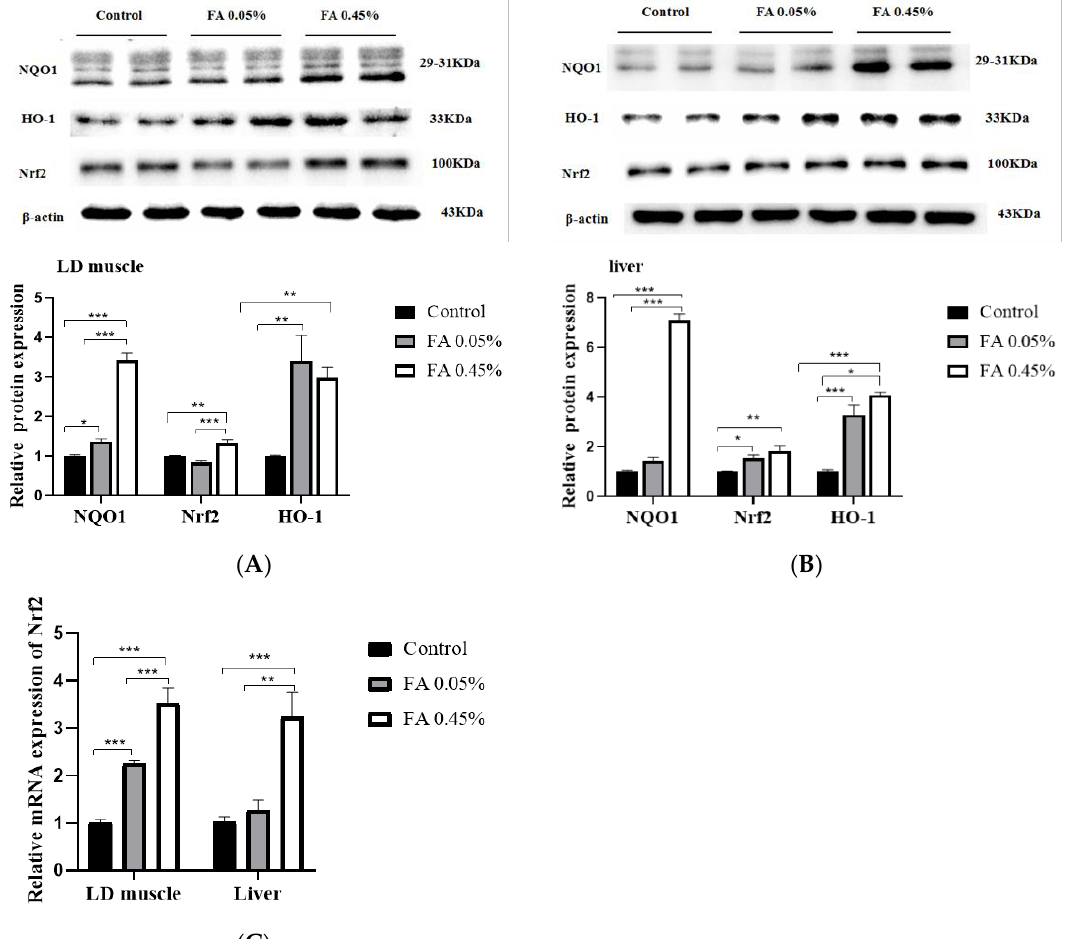
Figure 2. Effect of dietary FA supplementation on the expression of Nrf2-ARE signal components. ( A , B ) The protein levels of NQO1, Nrf2, and HO-1 in LD muscle and liver. Equal loading was monitored with an anti-β-actin antibody. ( C ) The mRNA abundance of Nrf2 in LD muscle and liver. The amount of target gene was normalized to the amount of GAPDH mRNA. Data were the mean and standard errors ( n = 6). * p < 0.05, ** p < 0.01, and *** p < 0.001. NQO1: NAD(P)H, quinone oxidoreductase 1, Nrf2: NF-E2-related nuclear factor 2, HO-1: heme oxygenase-1.